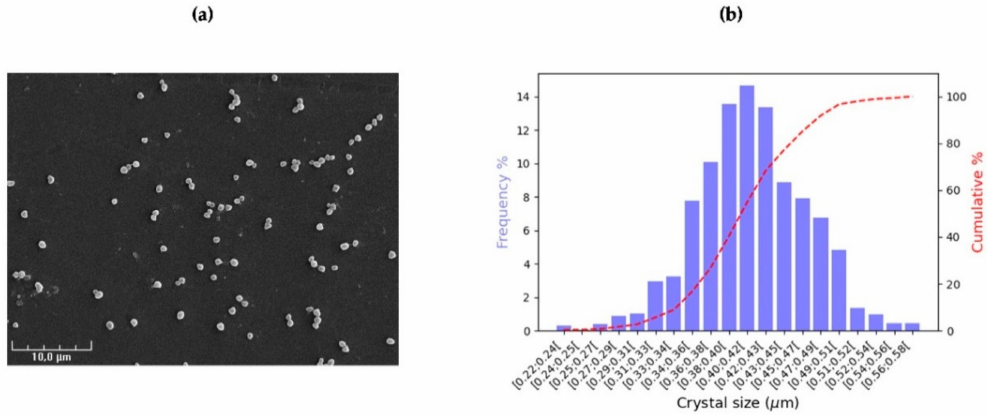
Figure 8. ( a ) SEM image taken of the H3 purified crystals. ( b ) Graph representing the radius size distribution in terms of frequency and cumulative percentage for the spherical crystals.